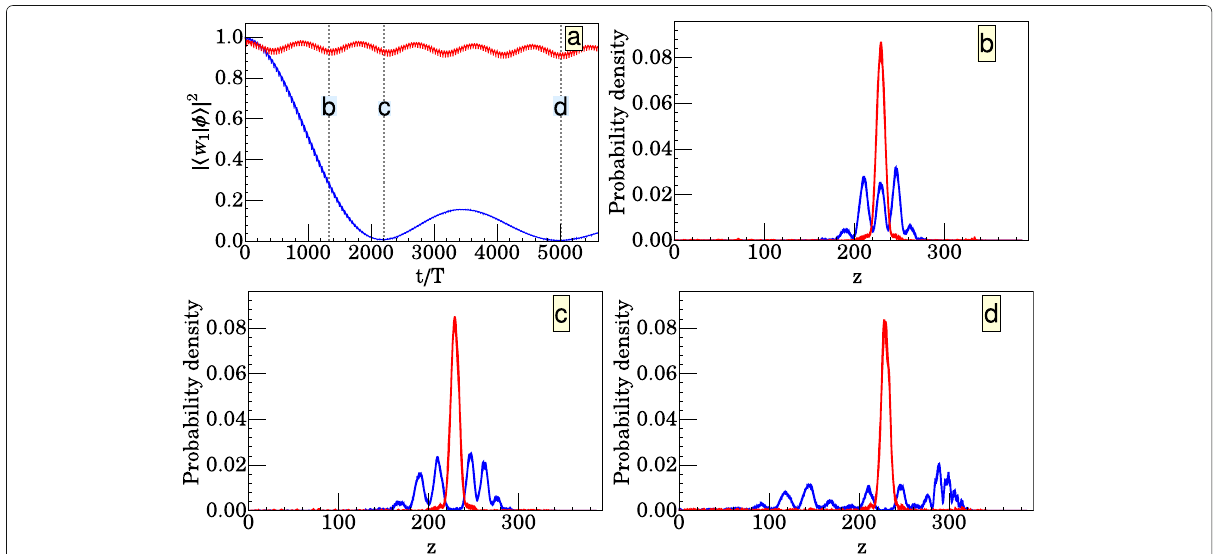
Fig. 1 Discrete time crystal formation for s = 40. In the absence of interactions (blue curves), atoms tunnel from the initial state to neighboring Wannier wave-packets which is indicated by the decrease of the overlap between the time-evolving wavefunction φ( z , t ) and the initially chosen w 1 ( z ,0 ) Wannier state (blue curve in (a)). When a sufficiently strong attractive interaction is turned on ( g 1 D N = − 0.12 ) , the system chooses a periodic solution evolving with a period 40 times longer than the period expected from the symmetry of the Hamiltonian, and the discrete time-translation symmetry is broken (red curves). In (b)-(d), the densities of interacting (noninteracting) atoms are presented with red (blue) curves at different moments in time: (b) t / T = 1330, (c) 2210 and (d) 5010. Parameters: λ = 0.2, ω = 4.9. Reprinted from [37]